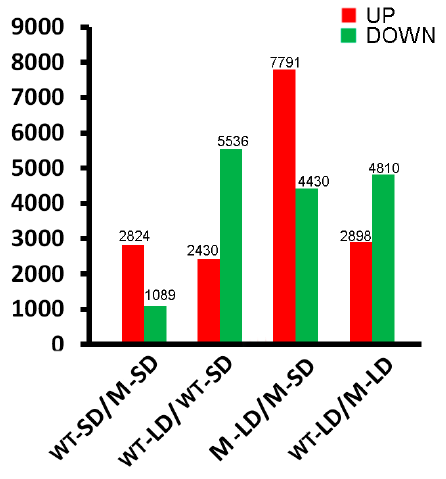
Figure 3. Numbers of differentially transcribed genes in WT and M plants grown under LD or SD. WT-SD represents wild type plants under short day conditions, WT-LD represents wild type plants under long day conditions, M-SD represents mutant plants under short day conditions, and M-LD represents mutant plants under long day conditions.